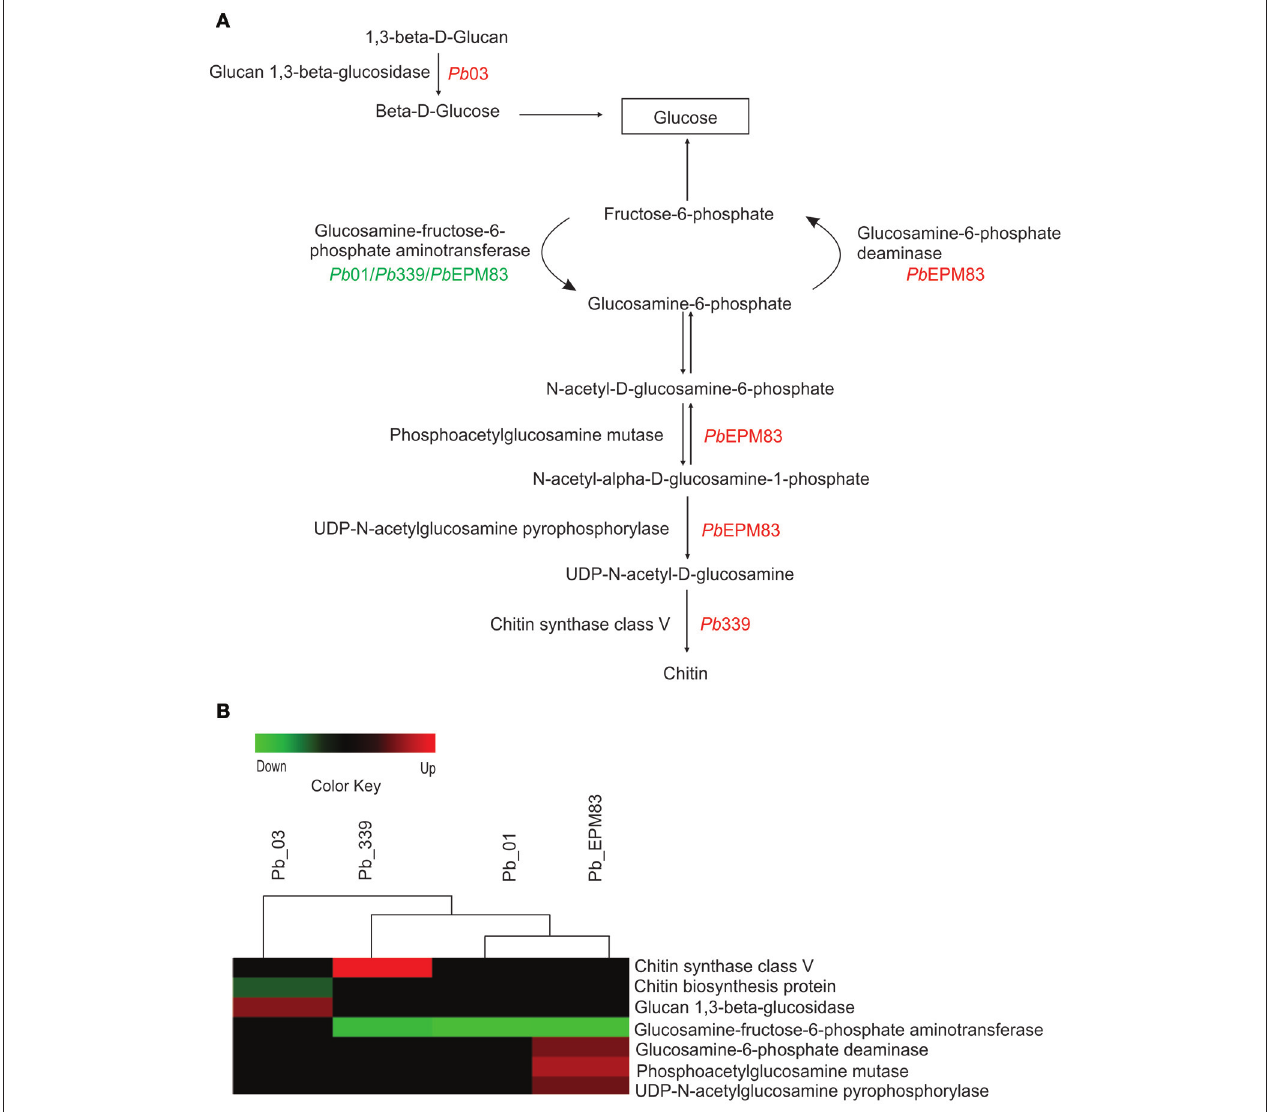
FIGURE 4 | Comparison of protein profiles related to cell wall metabolism in P. lutzii and isolates of P. brasiliensis . Dataset comparisons were carried out as cited in the Figure 2 legend. (A) Representative diagram of the cell wall metabolism pathways depicting down-regulated (green) and up-regulated (red) proteins in the isolates, as cited above. (B) Changes in expression levels upon yeast cells incubated with acetate in Pb 01, Pb 03, Pb 339, and Pb EPM83 are represented in a heat map format. Black indicates that no significant difference was